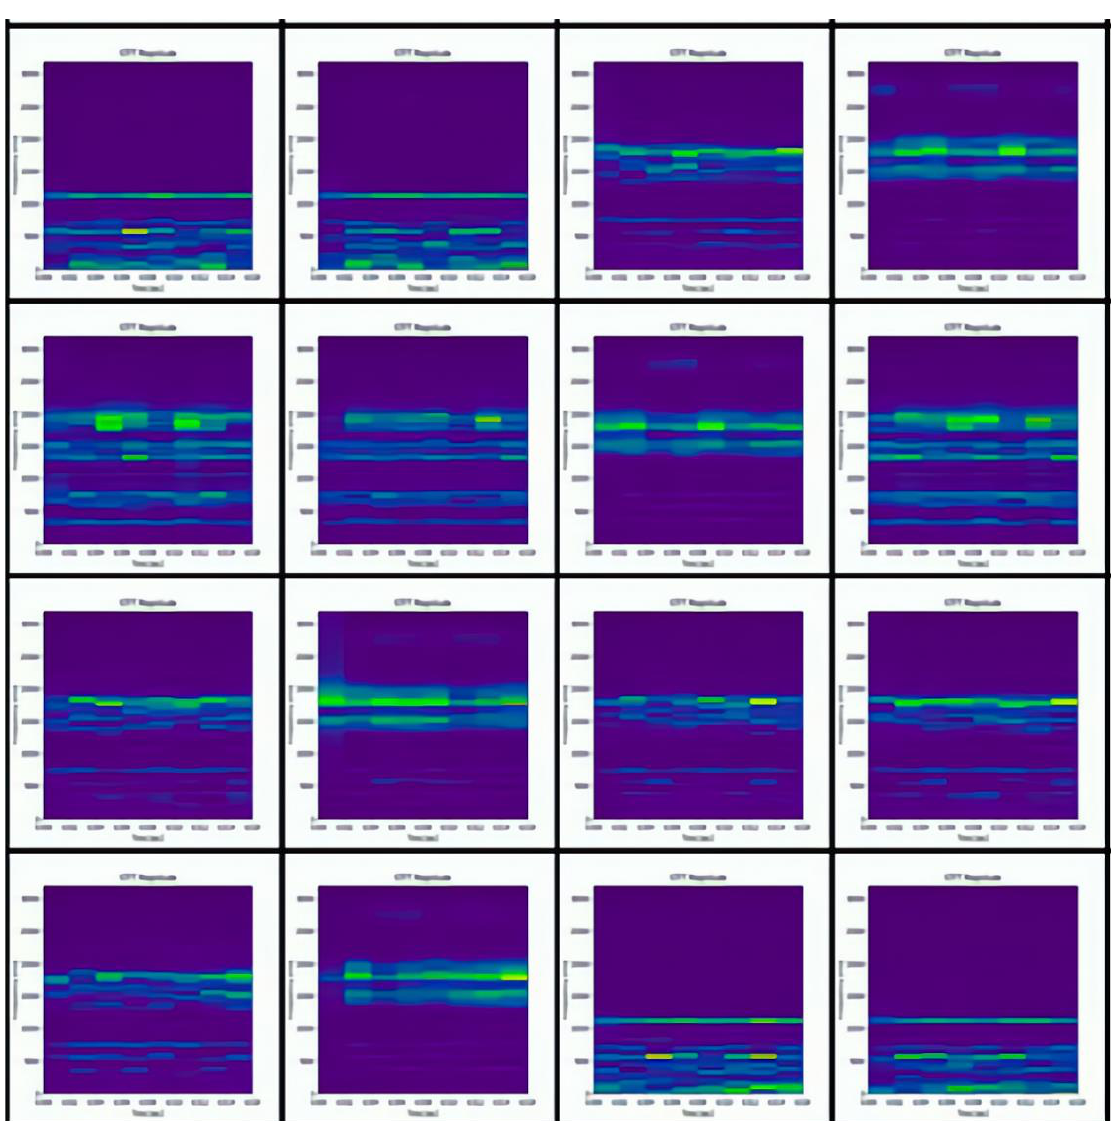
Figure 7. Part of fake samples in domain A generated by DCGAN.